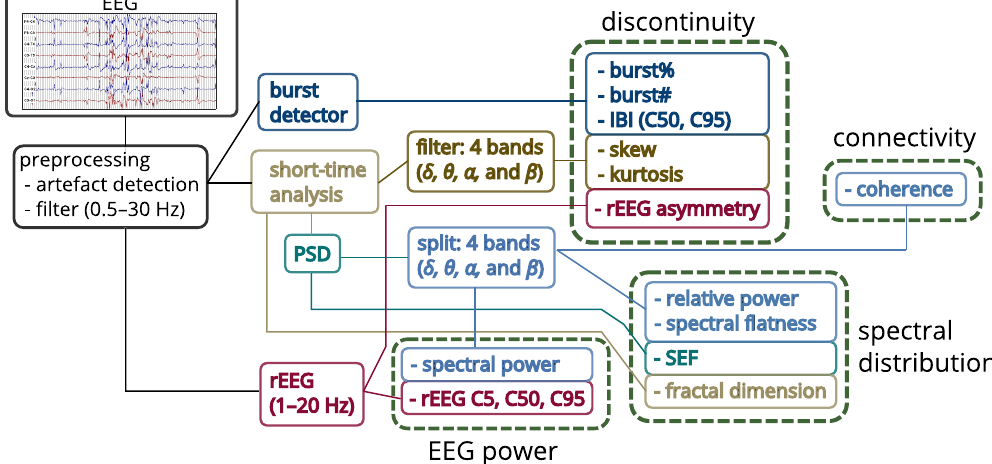
Figure 6. Outline of process to generate quantitative EEG. Features grouped as measures EEG power, spectral distribution, connectivity, and discontinuity. Frequency bands (FB): 0.5–3 Hz ( δ ), 3–8 Hz ( θ ), 8–15 Hz ( α ), and 15–30 Hz ( β ); C5, C50, and C95: 5th, 50th, and 95th centiles; SEF: spectral edge frequency; rEEG: range EEG; IBI: inter-burst interval; burst%: burst ratio; burst#: number of